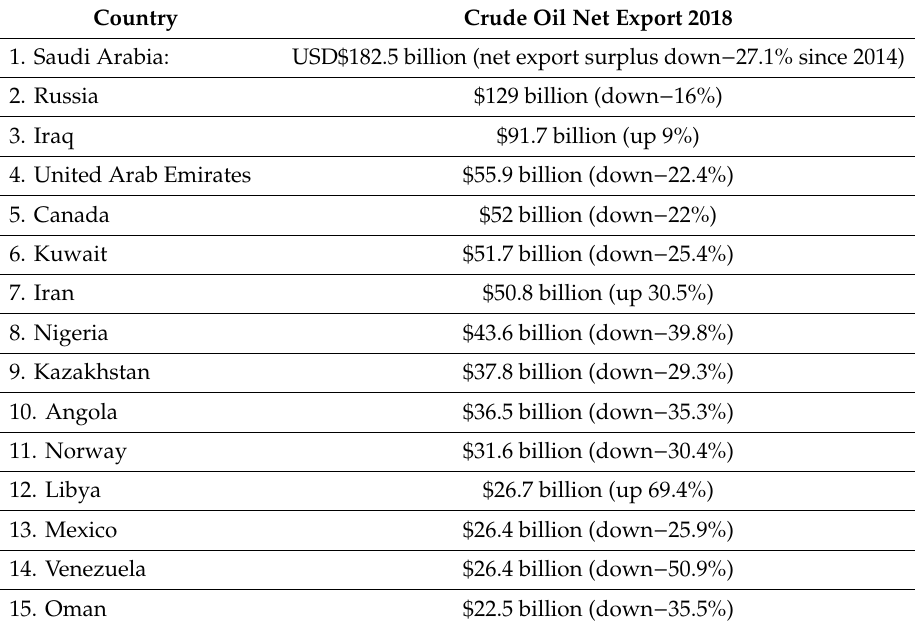
Table 3. Crude oil net exports by country—the world’s top 15 in